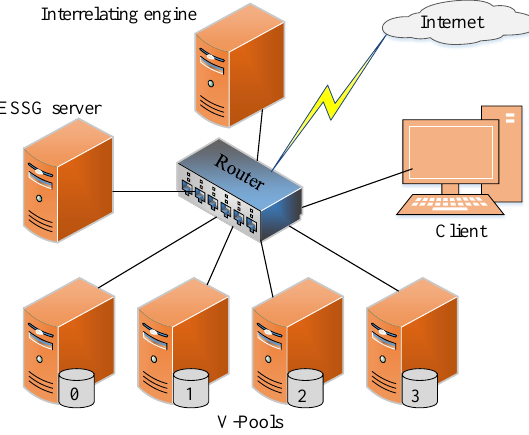
Fig.7 The environments of the GASE